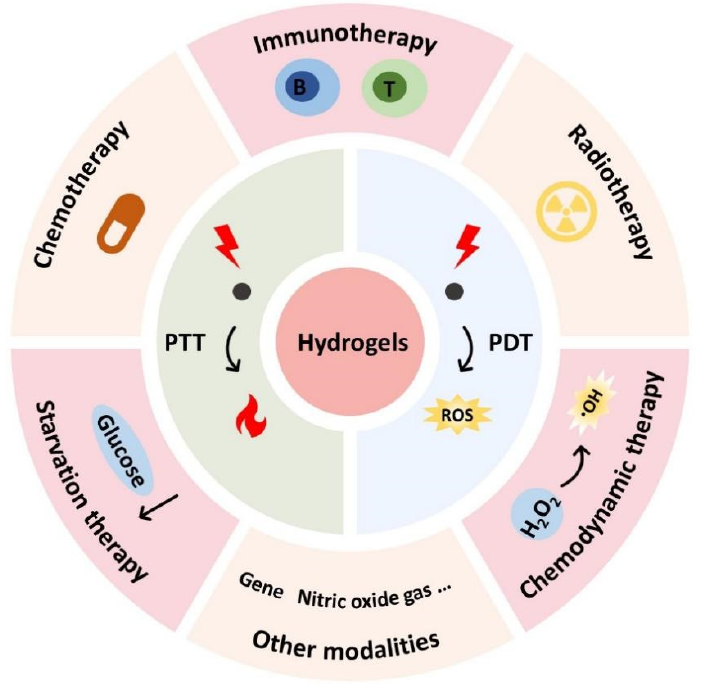
Figure 1. Schematic illustration of the hydrogels-based combinatorial phototherapy.